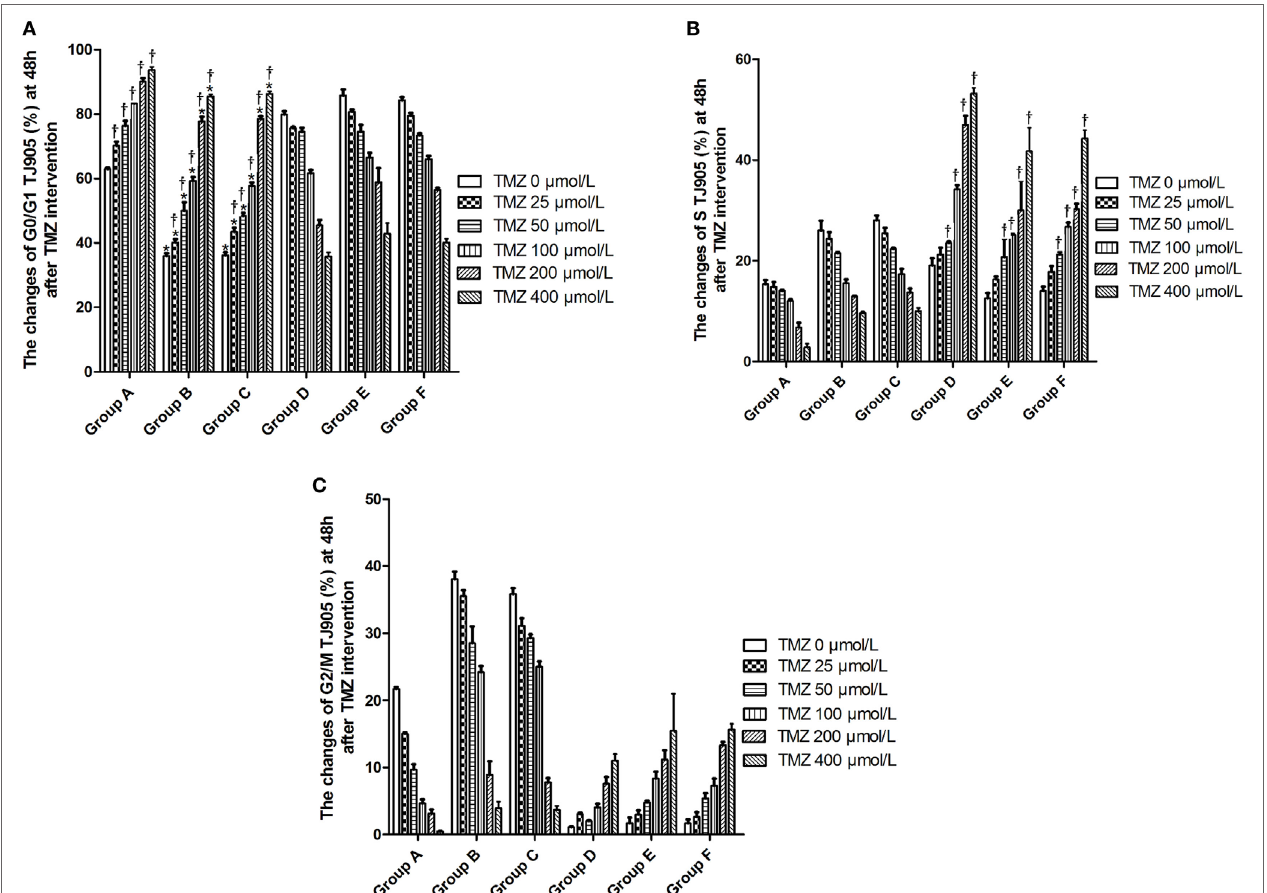
FigUre 10 | The changes of cell cycle at 48 h after temozolomide (TMZ) with different concentration interfering with TJ905 glioma cells (%). (a) G0/G1 phase; (B) S phase; (c) G2/M phase. * P < 0.05, compared with Group A in the same concentration; † P < 0.05 compared with the concentration of 0 µmol/L; # P < 0.05 compared with Group D in the same concentration. Group A: TJ905 cells transfected with Livin-shRNA, Group B: TJ905 cells transfected with negative-shRNA, Group C: the monolayer culture of TJ905 glioma cells, Group D: glioma stem cells transfected with Livin-shRNA, Group E: glioma stem cells transfected with negative-shRNA, and Group F: the monolayer culture of TJ905 glioma stem